Question: Generate an informative caption for the figure above.
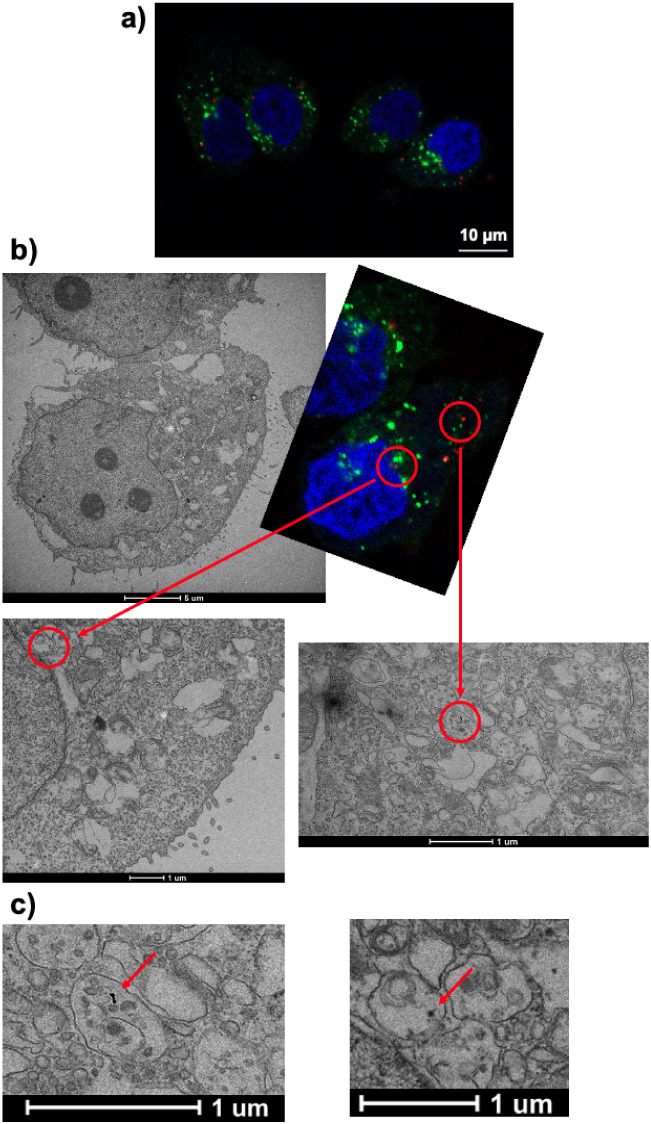
Answer: a) Confocal imaging of HeLa cells incubated with DiD’-Lipo-Gold for 1 h. Blue: nuclei; green: VPS35-GFP; red: DiD’-Lipo-Gold (single central slice from multiple 0.5 μm z-slices). b) Fluorescence and EM images of the cell of interest side by side, with correlation between red signal and presence of AuNPs in endosomal structures indicate by red circles. c) Higher-magnification images of the selected regions, highlighting AuNP-containing endosomal compartments corresponding to the fluorescence signal.